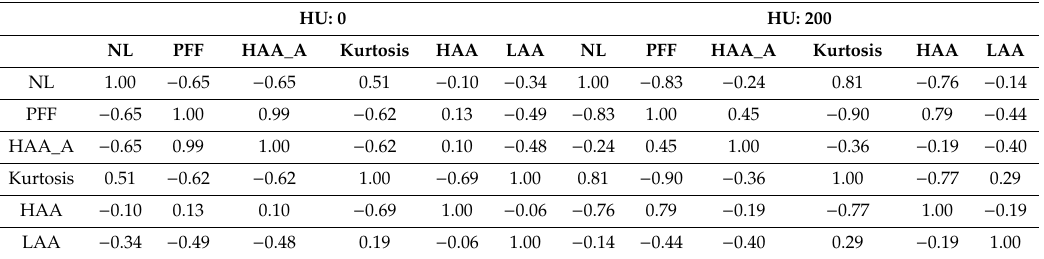
Table 4. Correlation matrix of HRCT histogram indices including NL, PFF, HAA_A, kurtosis, HAA and LAA at 0 and + 200 HU threshold. In NL, PFF, HAA_A, HAA, LAA parameters, the ‘%’ has been omitted for ease of